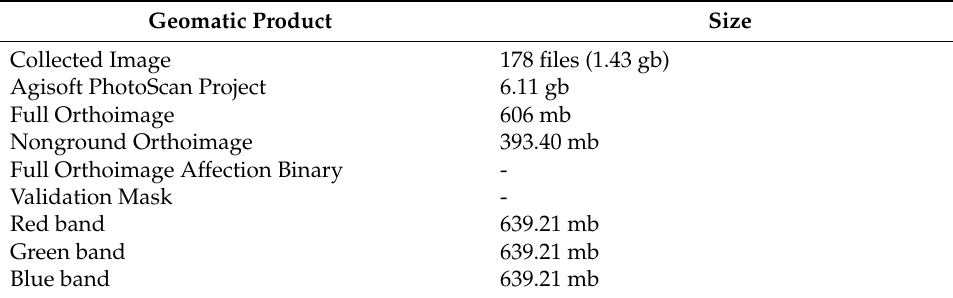
Table 3. Detected tie point and generated dense point cloud.